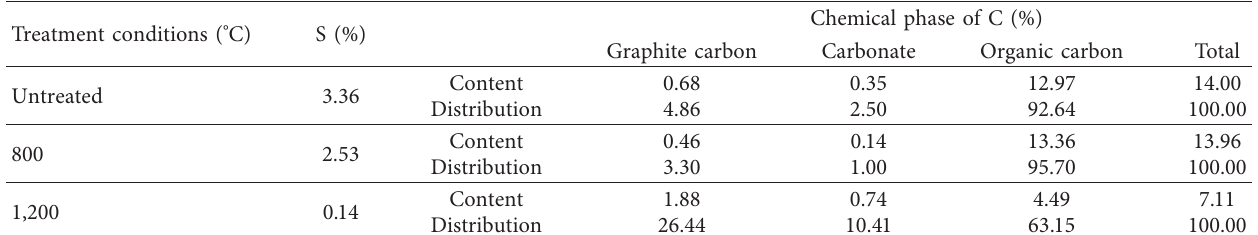
Table 4: Chemical phase analysis of C and S contents at different